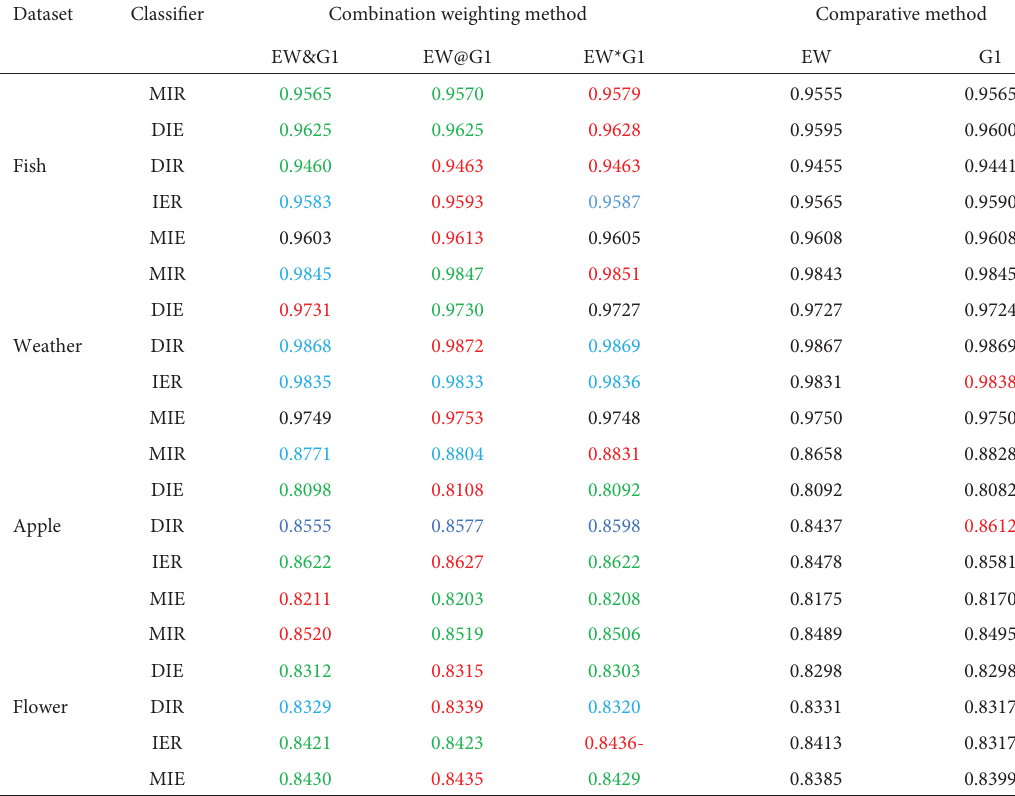
Table 6: Comparative study of four